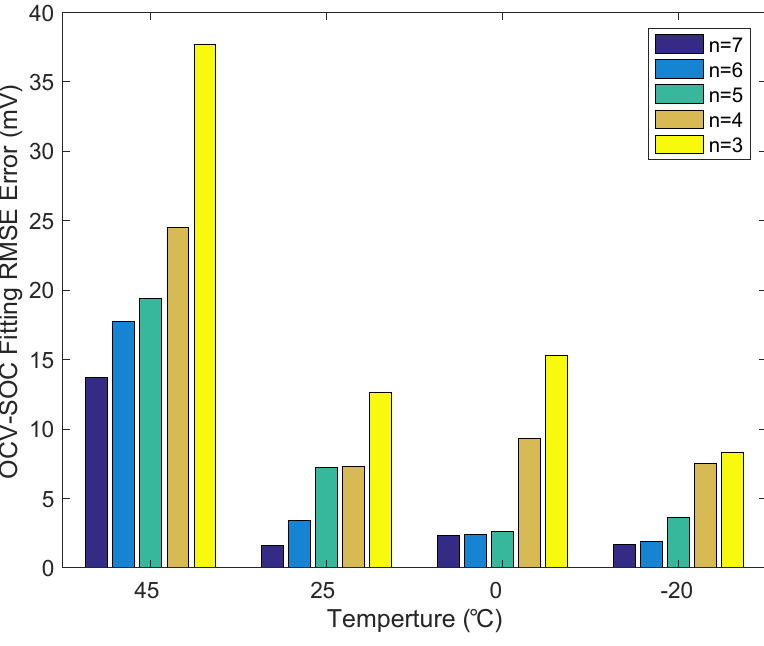
Figure 6. RMSE of polynomial fitting with different orders and different temperatures.